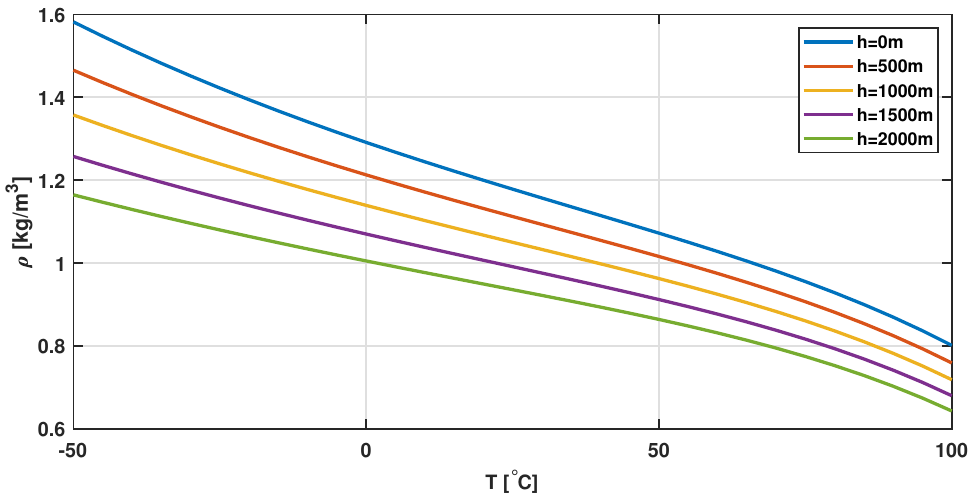
Figure 3. Temperature vs. air density with varying